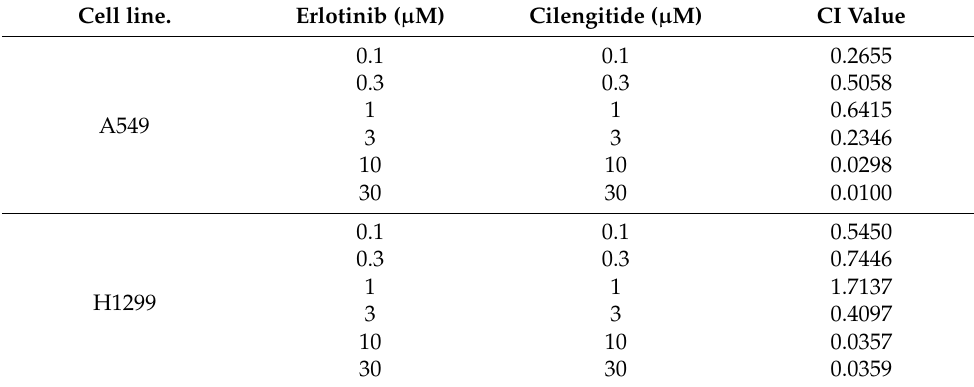
Table 1. Combination index (CI) values for the two-drug combination against A549 and H1299 cell viability. Cell